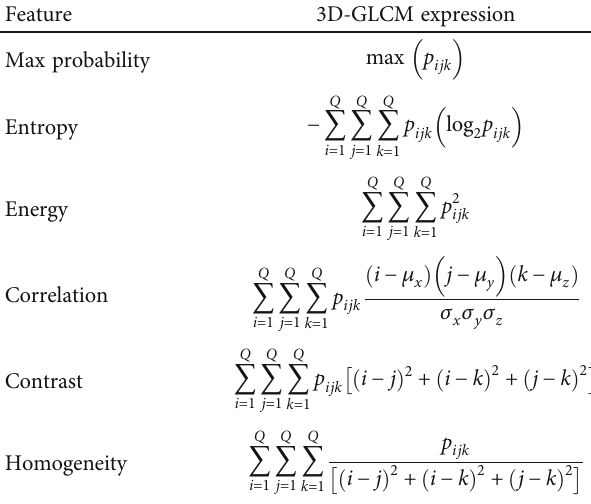
Table 1: Texture features calculated from